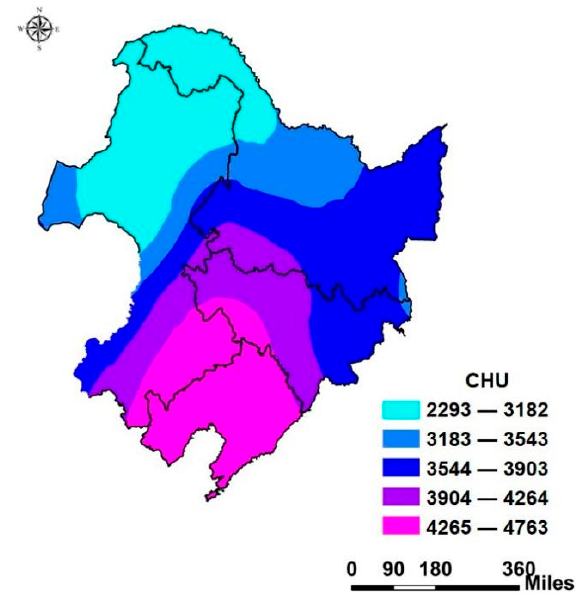
Figure 5. Distribution of annual CHU in Northeast China.